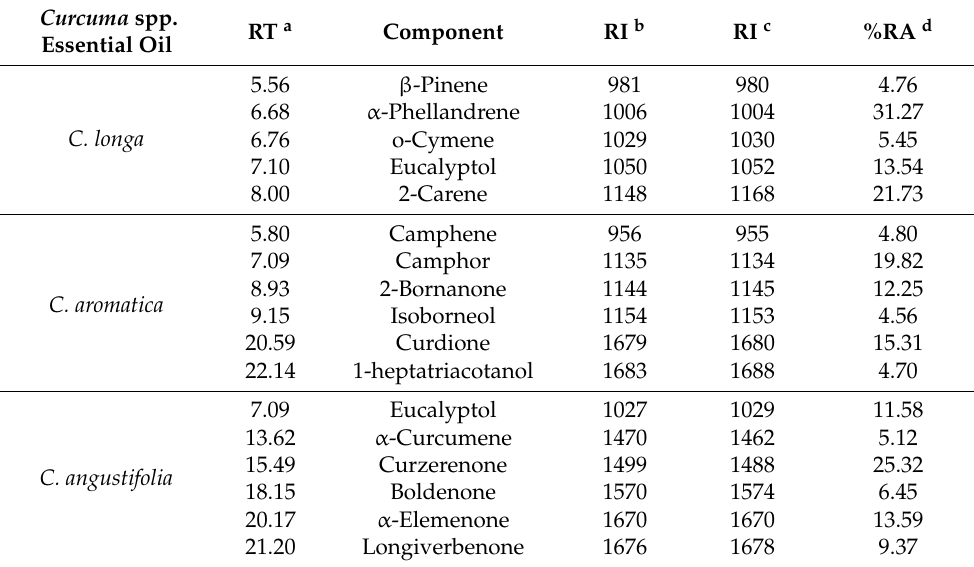
Table 2. The major compounds detected in the essential oil extracted from the leaves of different Curcuma spp. by GC-MS analysis.